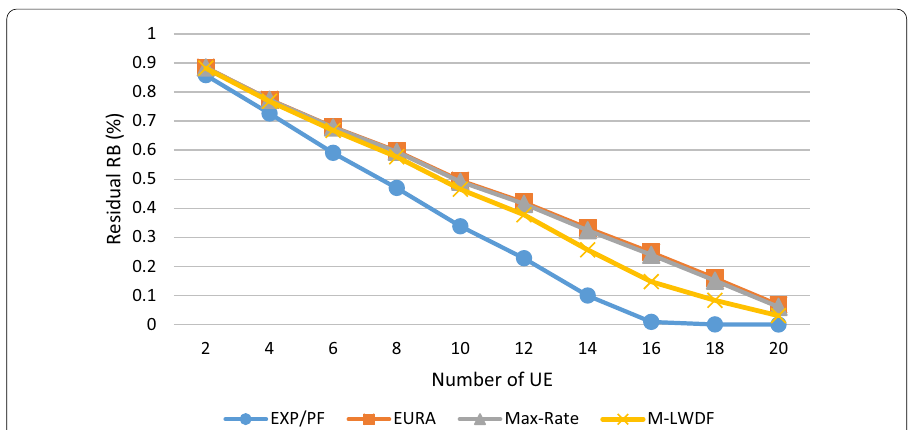
Fig. 10 Simulation result of residual RB’s rate; The performance comparison of residual RB’s rate for our proposed scheme and the contrasts